Question: What visual encoding does this figure use to show its data?
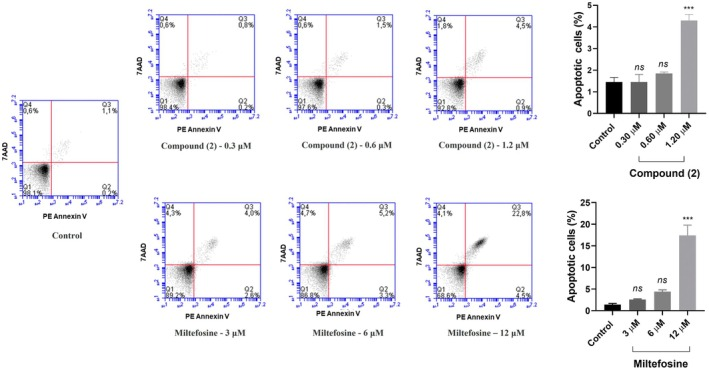
Answer: histogram